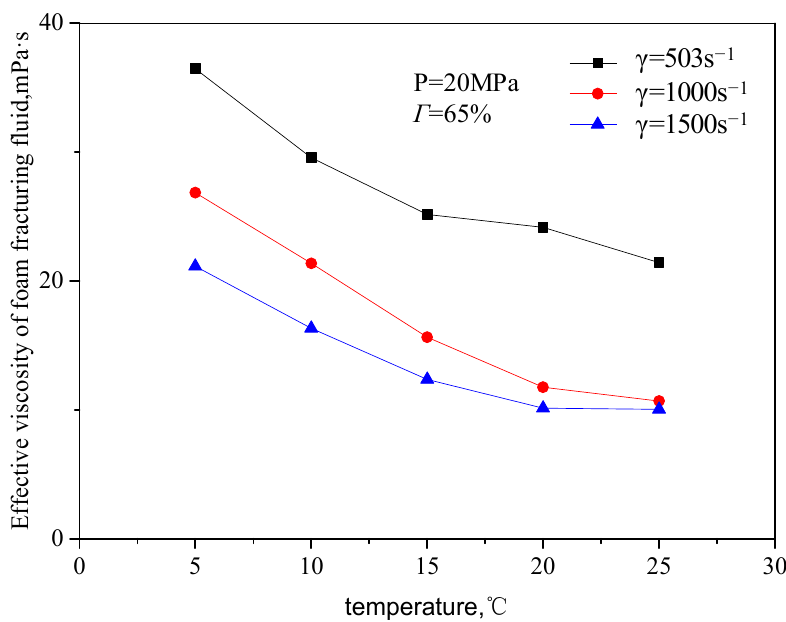
Figure 5. Variation curve of effective viscosity with temperature (unfoamed, 65% by volume).